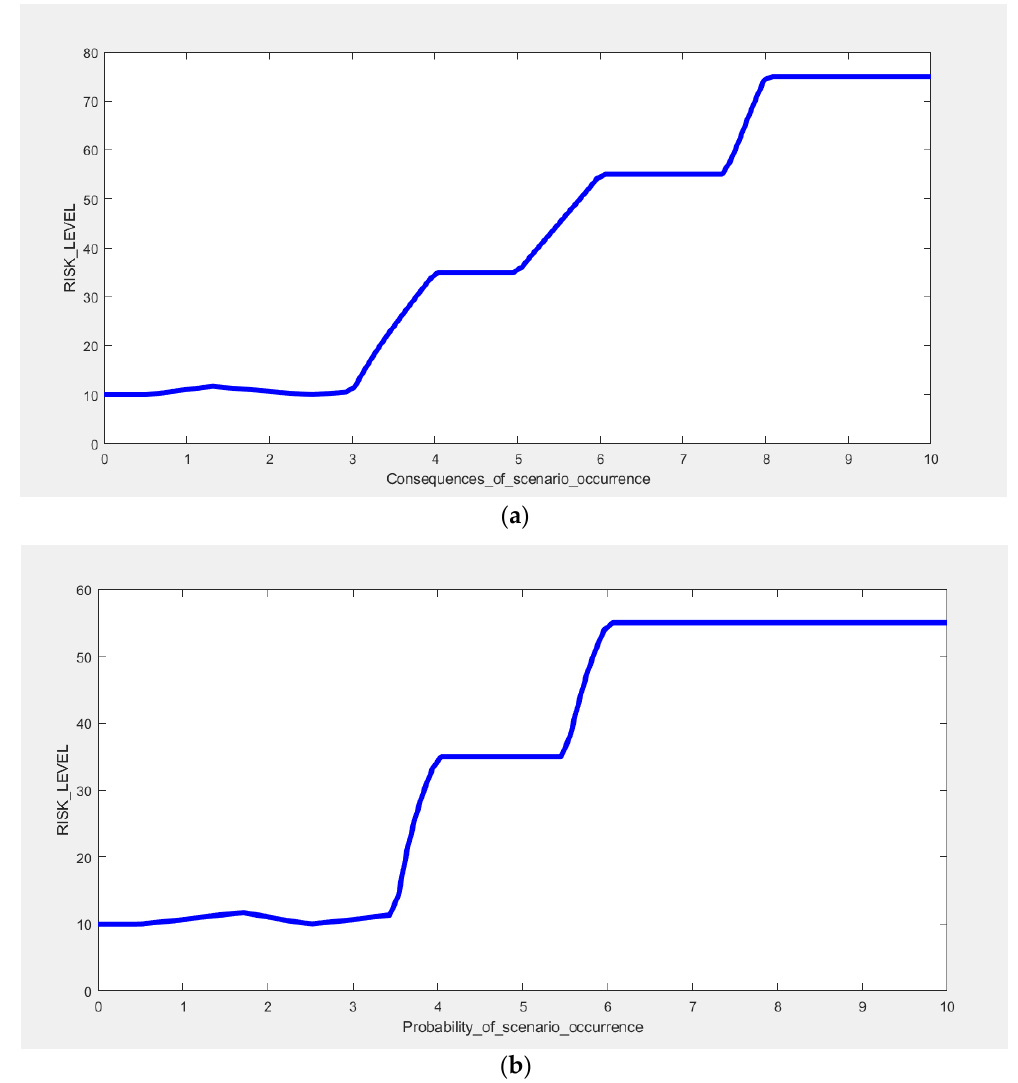
Figure 10. The influence of the input function course on the obtained risk level results: ( a ) function of Probability of scenario occurrence; ( b ) function of Consequences of scenario occurrence.